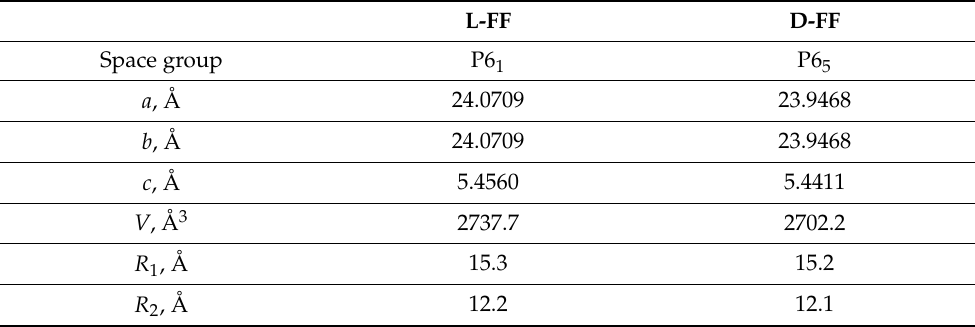
Table 1. Experimental lattice cell parameters for L-FF [31] and D-FF [38] PNTs and inner cavity sizes R 1 , R 2